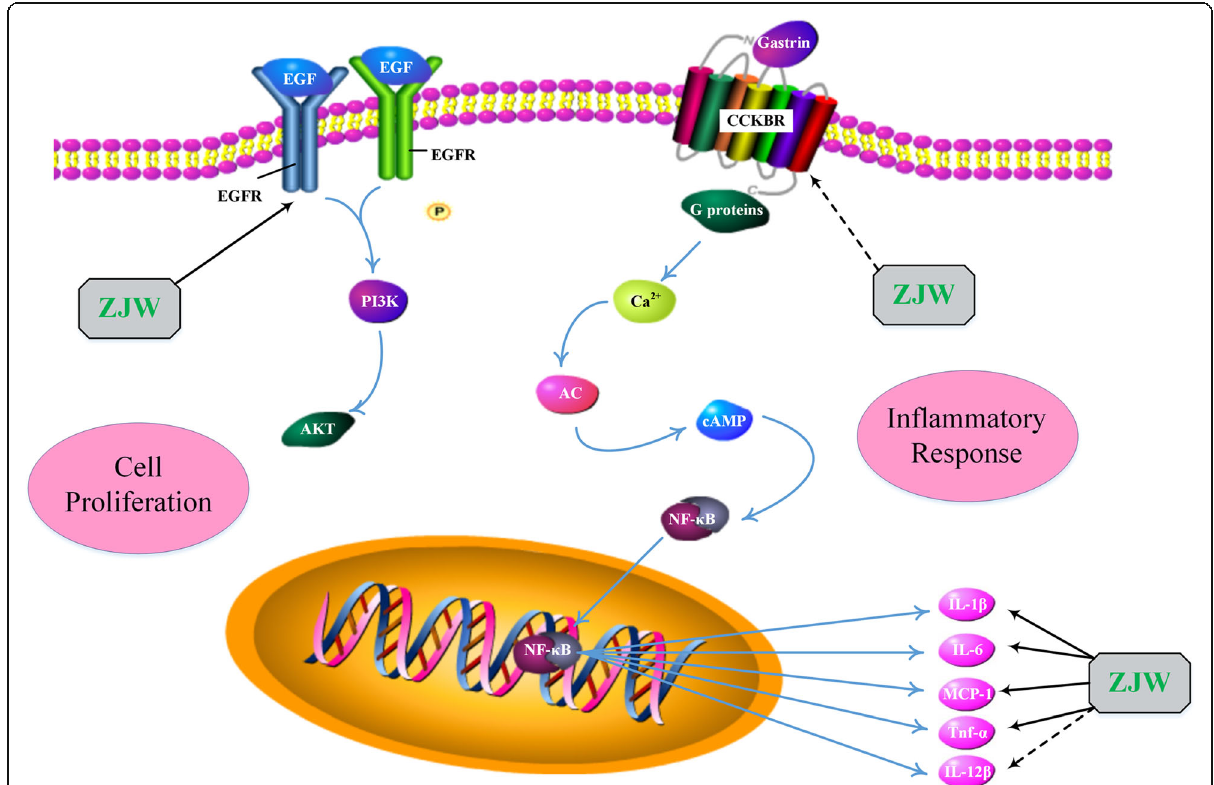
Fig. 5 Illustration of crucial biological progress caused by putative targets and known therapeutic targets for gastritis. Abbreviations: EGF, epidermal growth factor; EGFR, epidermal growth factor receptor; CCKBR, cholecystokinin-B receptors; PI3K, phosphoinositide 3-kinase; AKT, protein kinase B; Ca 2 + , Calcium ion; AC, adenylyl cyclase; cAMP, cyclic adenosine monophosphate; NF- κ B, nuclear factor kappa B; IL-1 β , interleukin 1 beta; IL-6, interleukin 6; MCP-1, monocyte chemotactic protein-1; TNF- α , tumor necrosis factor alpha; IL-12 β , interleukin 12 beta; ZJW,